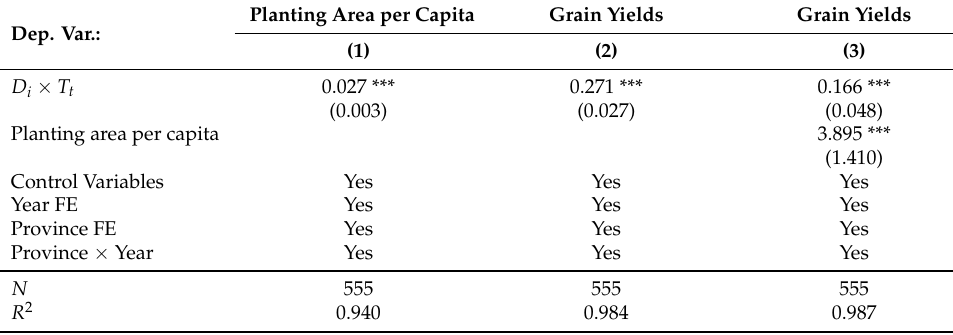
Table 11. Channel 1—expanding planting areas. Dep.